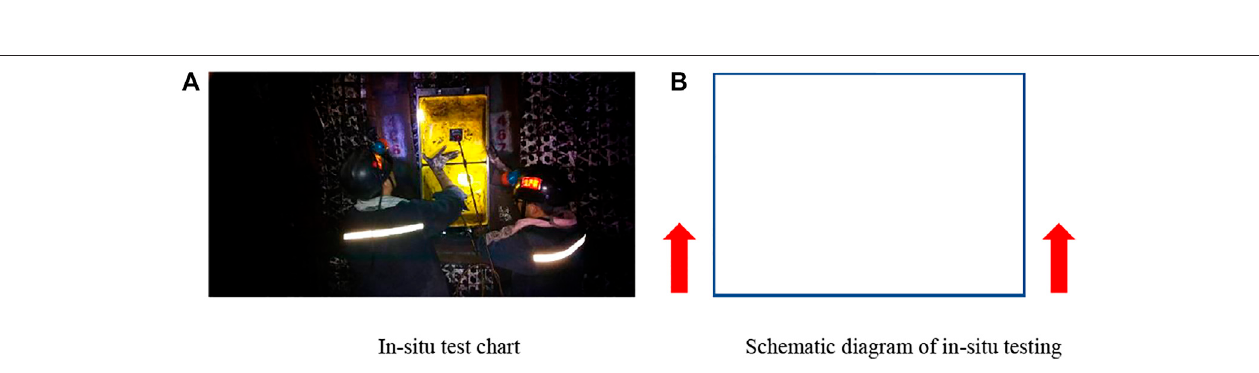
FIGURE 9 | Schematic diagram of in situ test. (A) In situ test chart. (B) Schematic diagram of in situ testing.